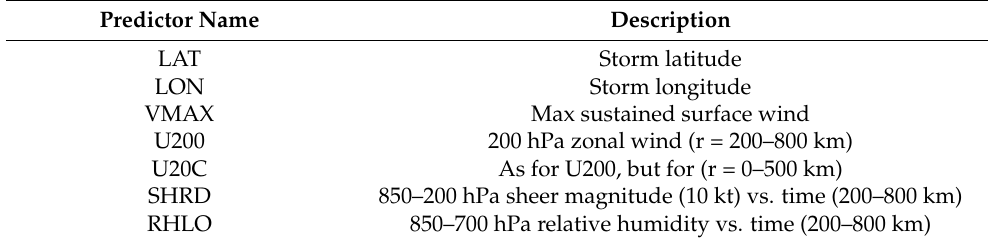
Table 1. Selected predictors in the SHIPS database.